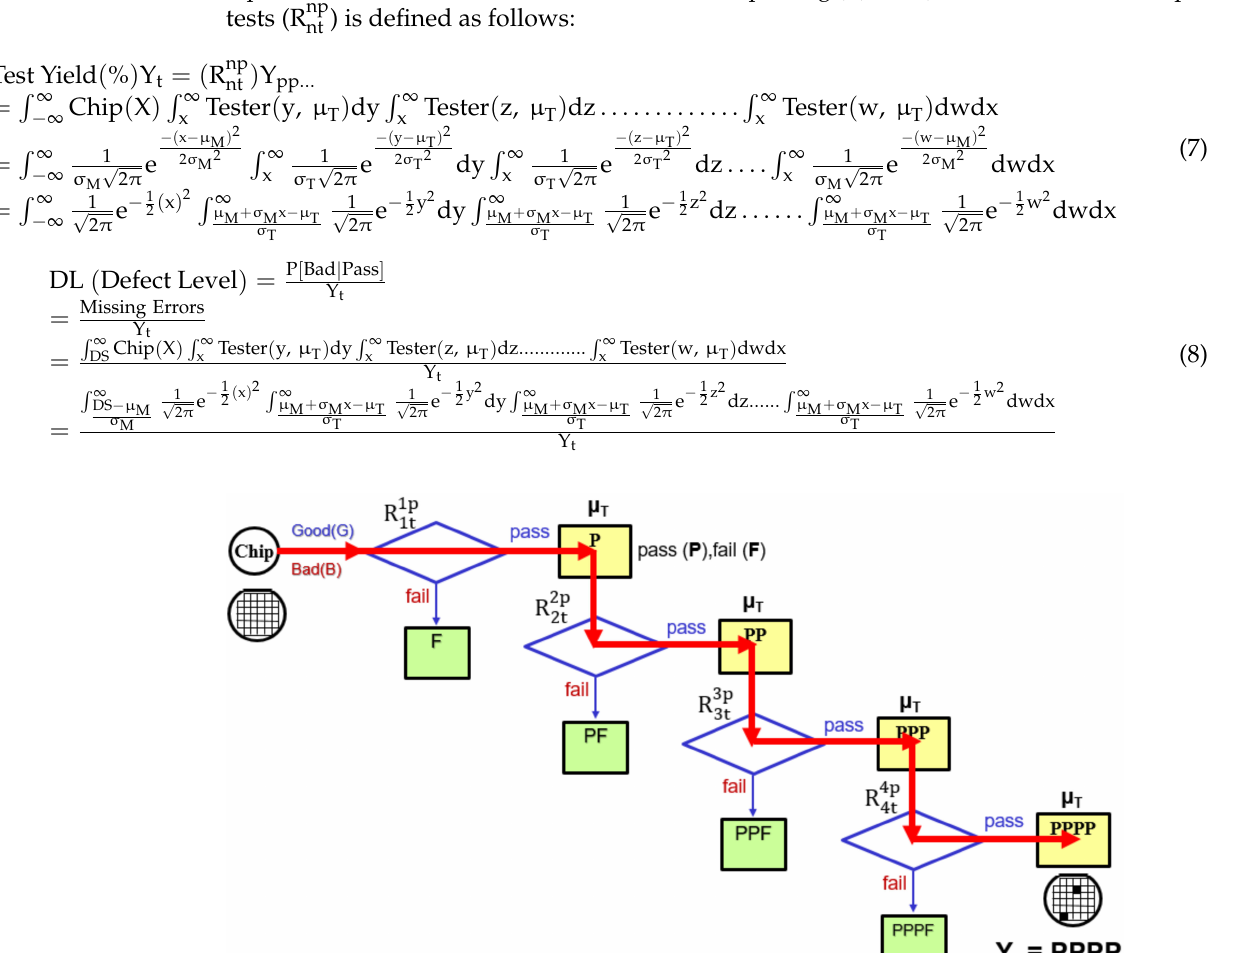
Figure 8. Method of repetition tests scheme R np